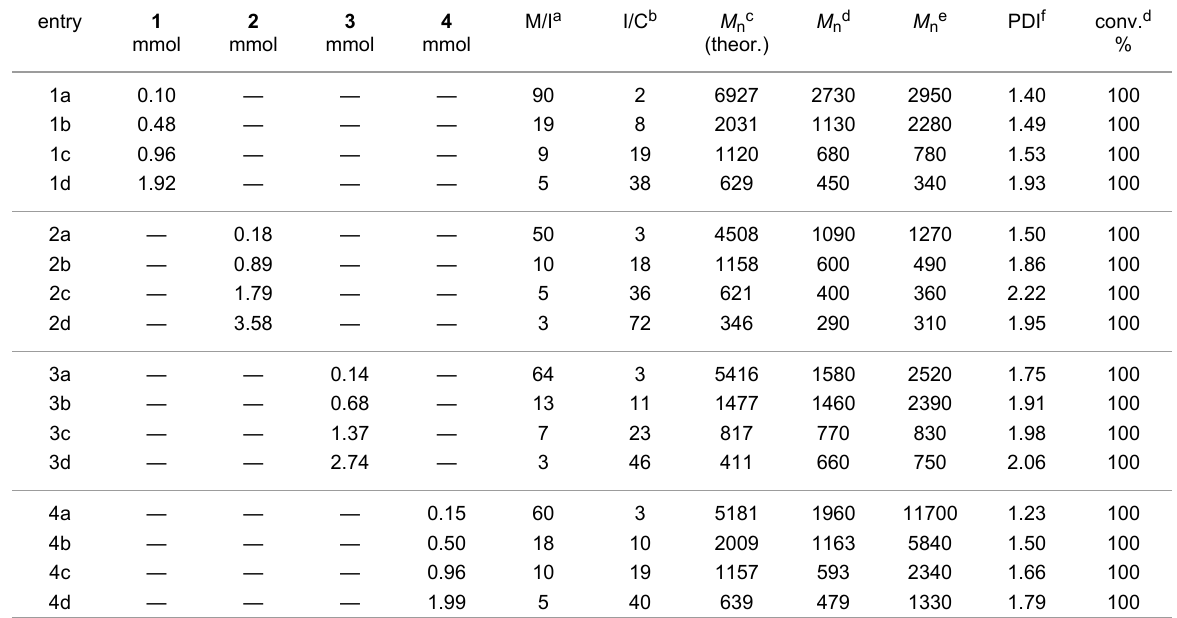
Table 1: Ring-opening polymerization of ε -CL in the presence of alcohol initiator [benzyl alcohol ( 1 ), ethylene glycol ( 2 ), glycerol ( 3 ) or pentaerythritol ( 4 )], initiated in vacuo at 75 °C for 75 min.